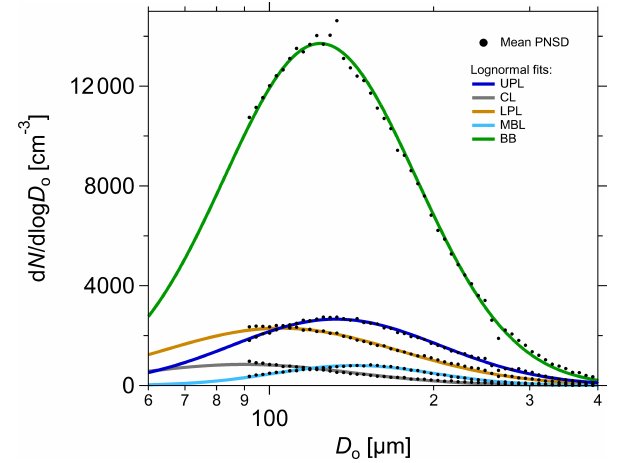
Figure 4. Particle number size distributions (PNSD) measured by the UHSAS for the UPL, CL, LPL, and MBL, as defined in Fig. 3, and the fresh BB plume probed during AC19 (see Fig. 1). The data points (black dots) are fitted by log-normal functions between 90 and 500nm (Heintzenberg, 1994). Table 2. Fit parameters of UHSAS-derived aerosol size distri- butions in Fig. 4, representing different conditions (i.e., layers,